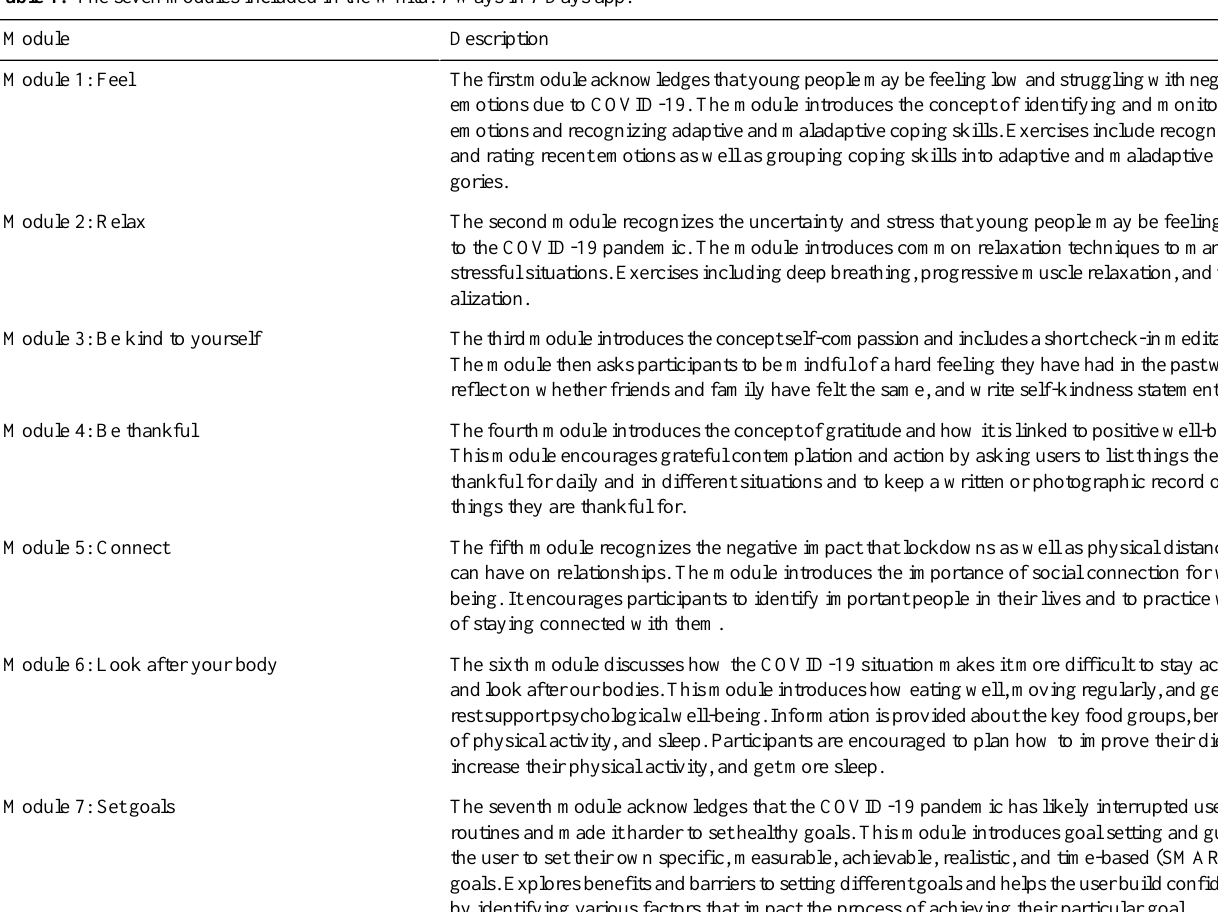
Figure 2. Screenshots of the onboarding process of the Whitu: 7 Ways in 7 Days app.